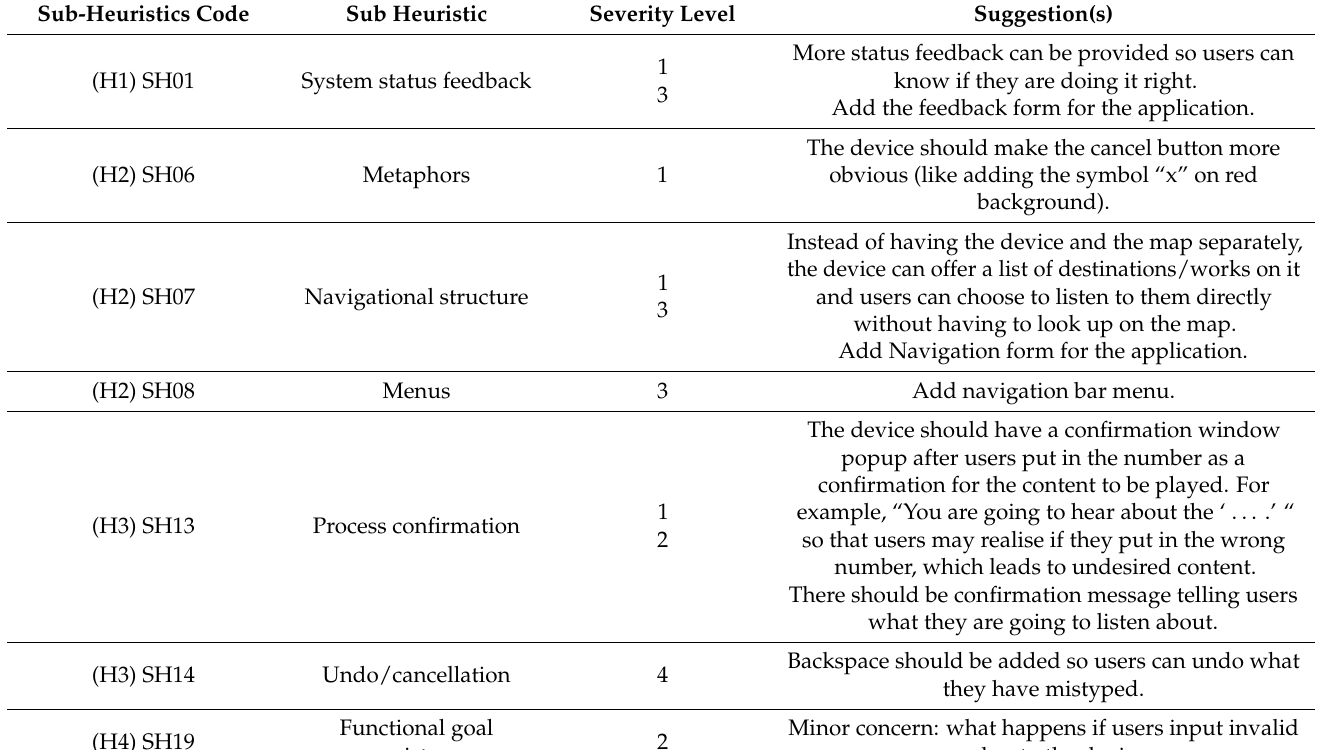
Table A7. UX Experts’ Suggestions for the TL’s Audio